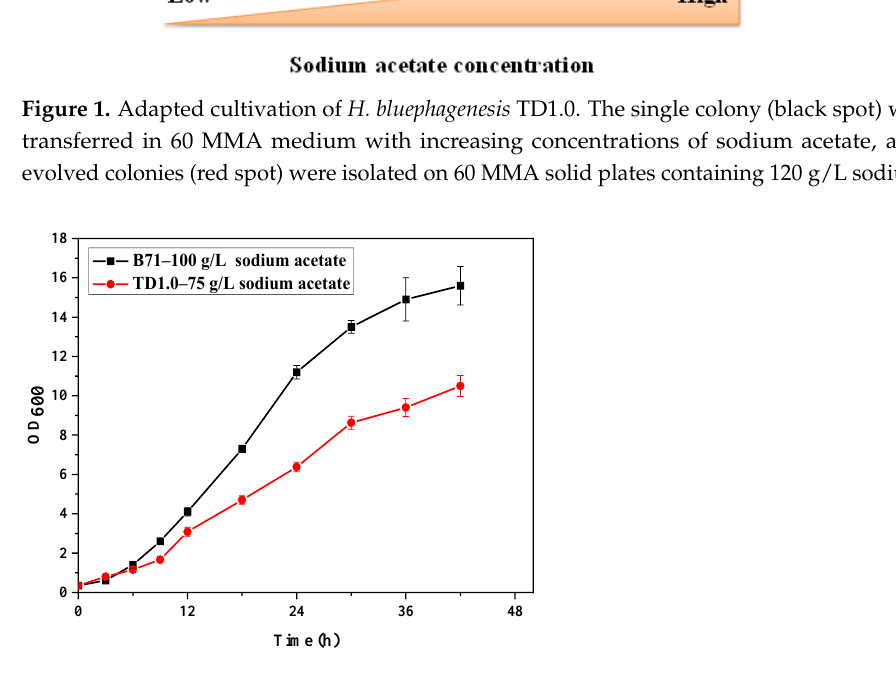
Figure 2. Comparison of acetate tolerance of the evolved strain B71 (black solid square) and the parental strain TD1.0 (red solid circle). B71 and TD1.0 were grown in 60 MMA minimal medium containing 100 g/L and 75 g/L sodium acetate, respectively. Error bars represent standard deviation (SD), n = 3.